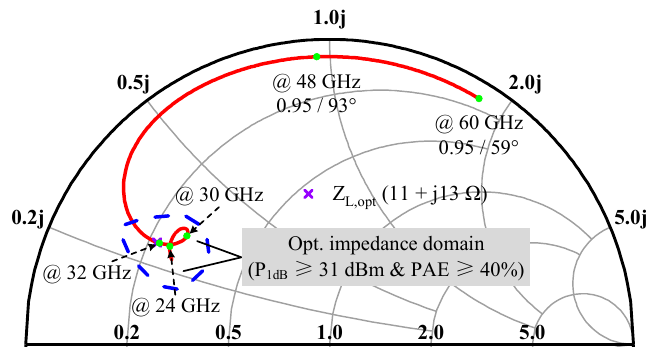
Figure 7. Simulated S 11 of OMN in EM layout format.